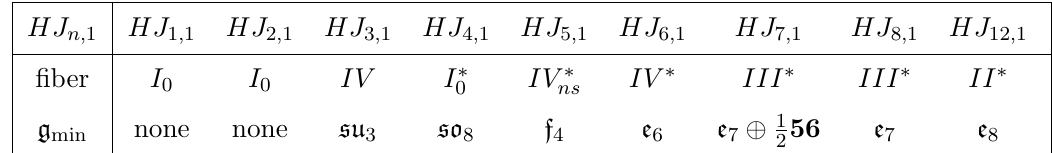
Table 1 . Minimal gauge groups for the 6d theories of rank 1. For n = 1 one obtains the E-string theory, the theory describing a single heterotic E 8 instanton that has shrunk to zero size. As H 2 ; 1 is a Du Val singularity of type A 1 , the surface is a local CY 2-fold and one obtains the A 1 (2,0) SCFT. The model corresponding to HJ 7 ; 1 contains some charged matter in the 1